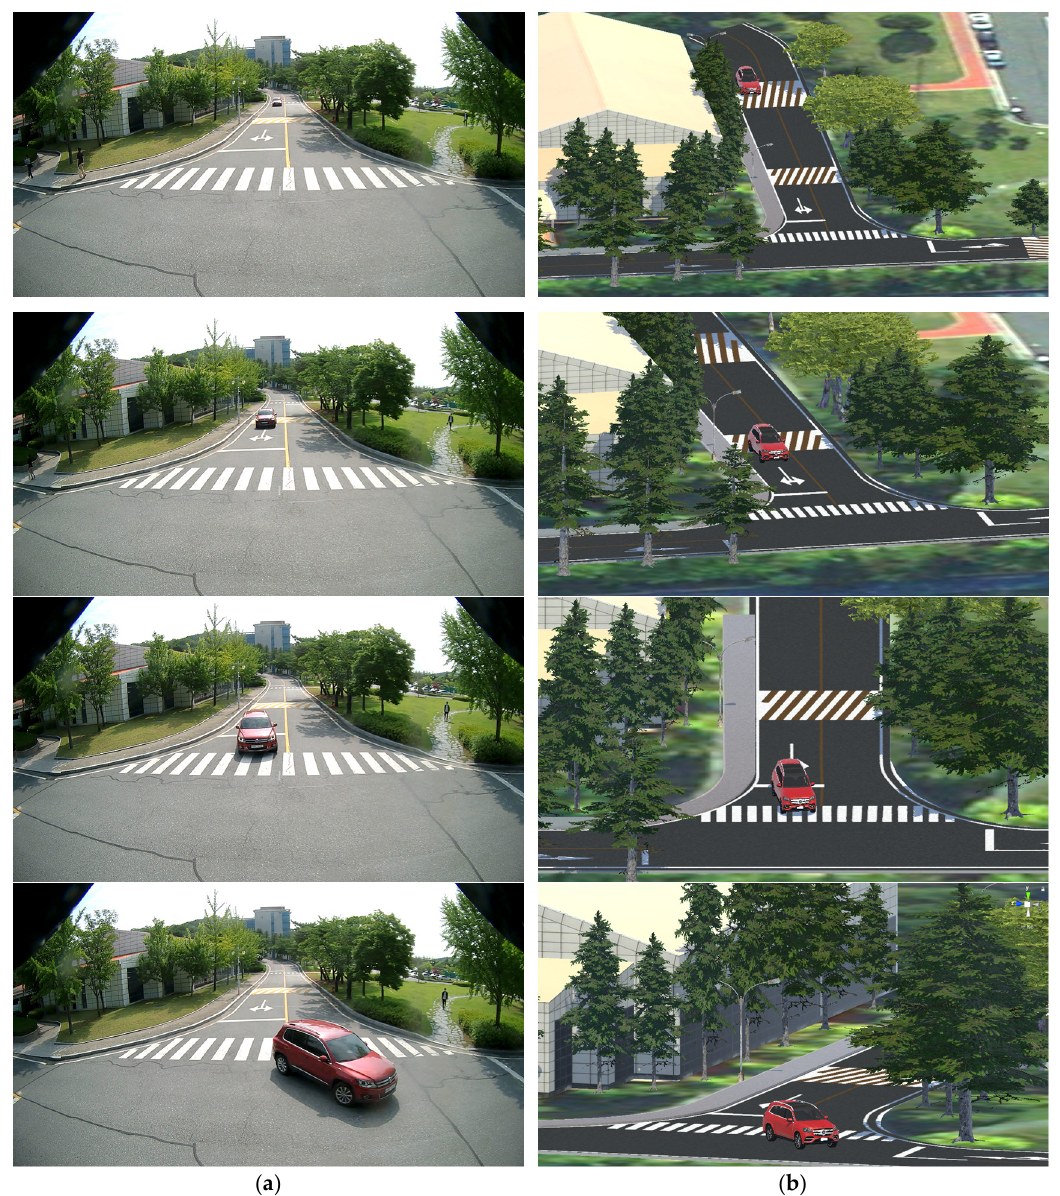
Figure 14. Visualization result for an urban digital twin model with individual mobility objects in our testbed: ( a ) closed-circuit television video; ( b ) digitized terrain, buildings, road facilities (e.g., lanes, crosswalks, speed bumps, curbs) and individual mobility objects.